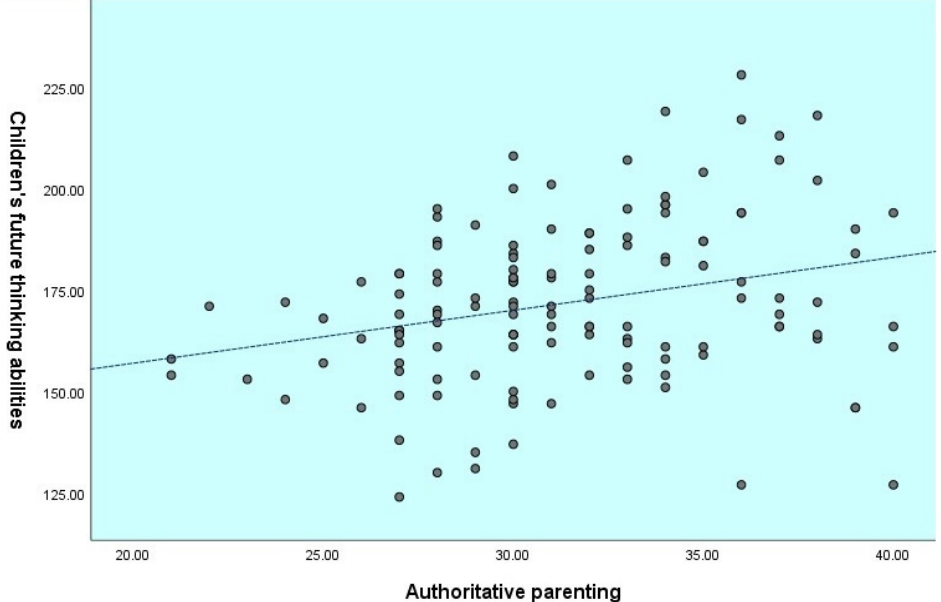
Figure 2. Correlation between authoritative parenting and children’s future-oriented cognition total score.